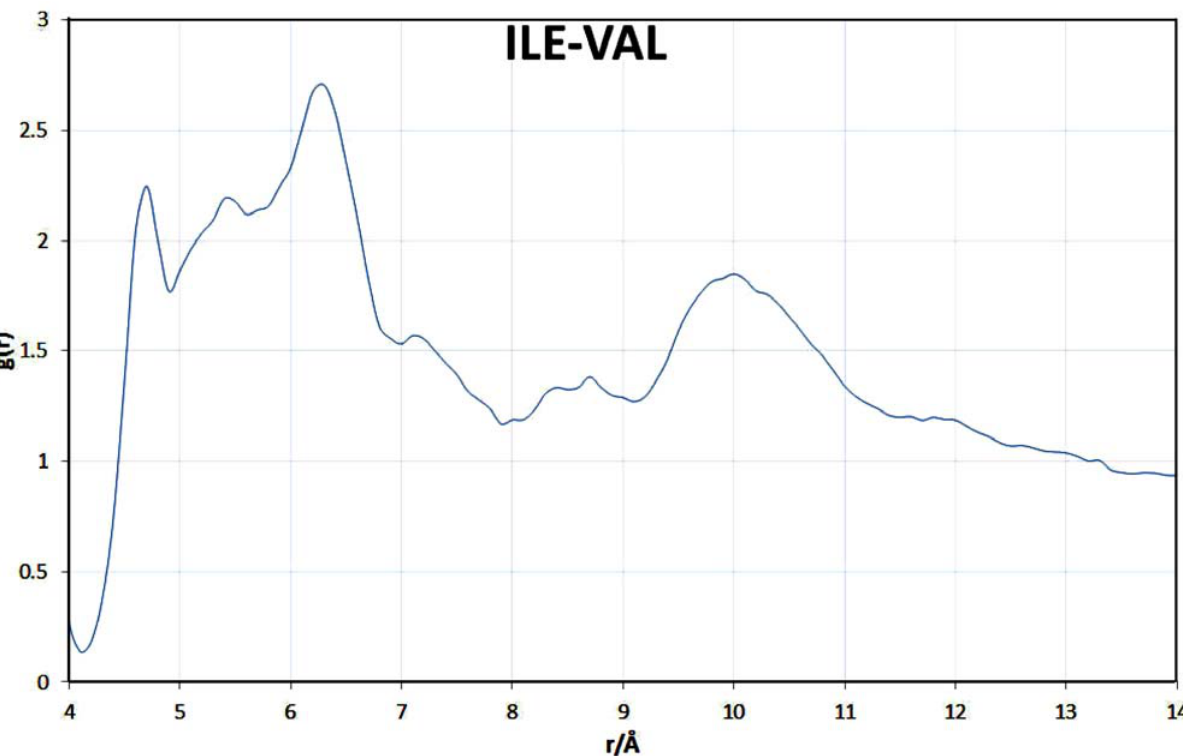
Figure 5. Radial distribution function for the pair